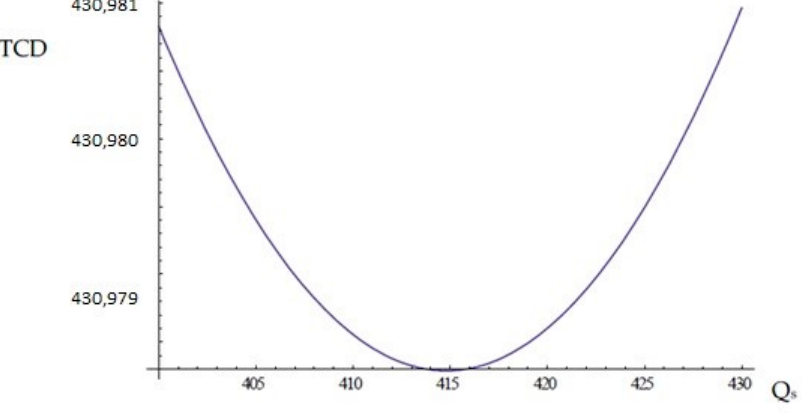
Figure 5. TCD vs. W graph.